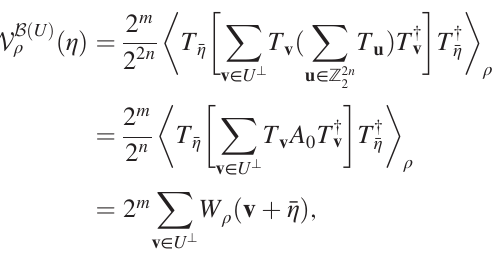
FIG. 1. Wigner function of the three-rebit graph state ∣ K 3 i corresponding to the complete graph K 3 . The Wigner function takes negative values, and furthermore this negativity is strong enough to witness contextuality of ∣ K 3 i with respect to CSS-ness preserving Pauli